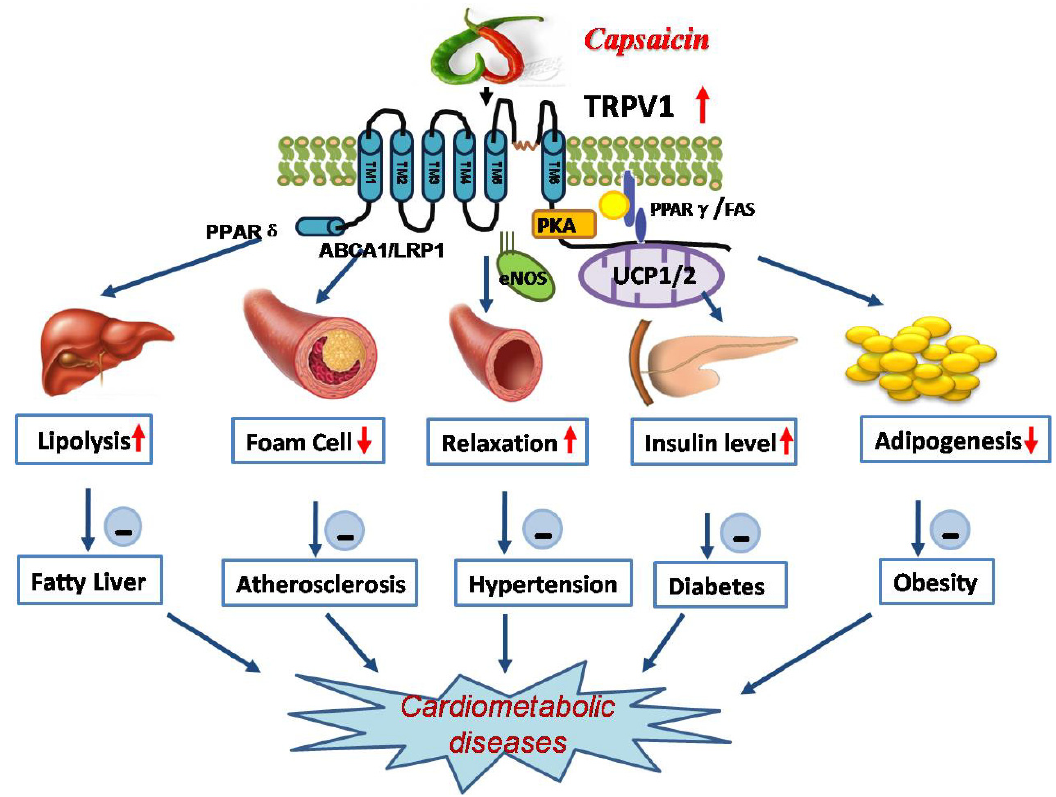
Figure 2. Favorable effects of capsaicin on cardiometabolic disease or related target organ damage. Activation of TRPV1 by dietary capsaicin plays a critical role in the regulation of lipid and glucose metabolism and vascular function, including the promotion of lipolysis by activating PPAR δ , the improvement of vasodilation by increasing eNOS expression, the upregulation of insulin levels by activating PKA, the inhibition of foam cell formation by regulating ABCA1 and LRP1 levels, and the suppression of adipogenesis by activating PPAR γ . Therefore, dietary capsaicin can alleviate fatty liver, atherosclerosis, hypertension, diabetes, and obesity. Dietary capsaicin has potential benefits for cardiometabolic diseases in the population.